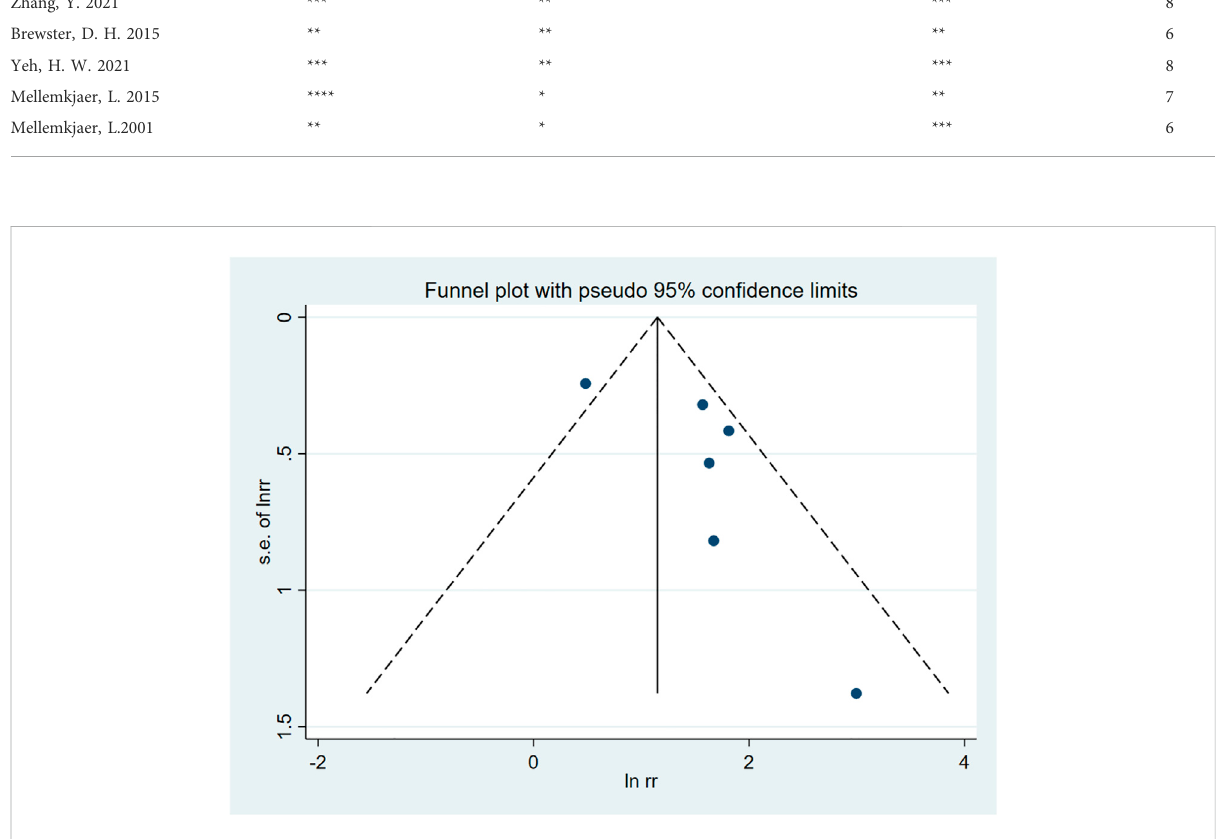
FIGURE 2 Funnel plot of publication